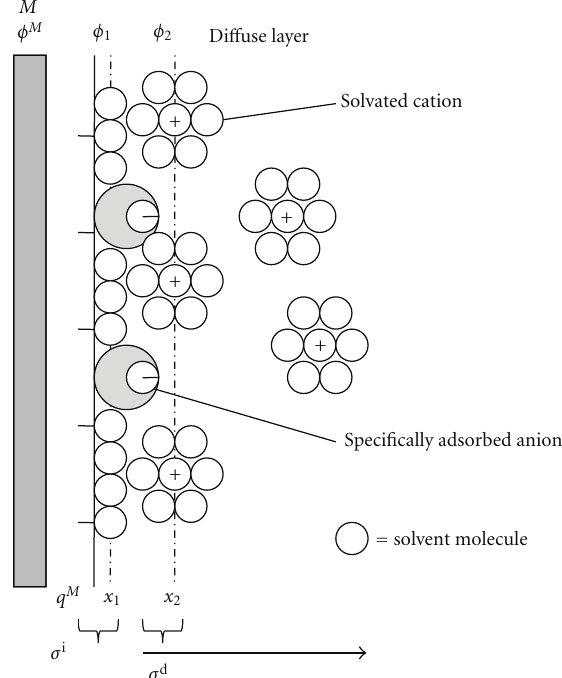
Figure 2: Double layer region ([27], reproduced with